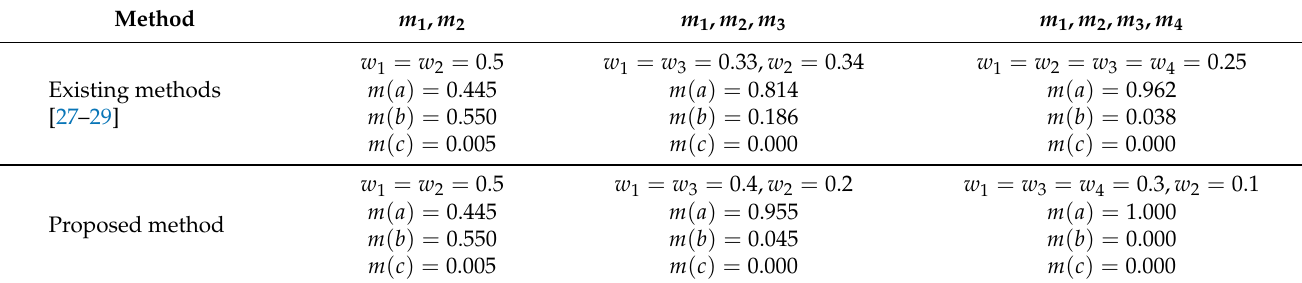
Table 6. The result of combining conflicting evidence with different methods in the Example 12.